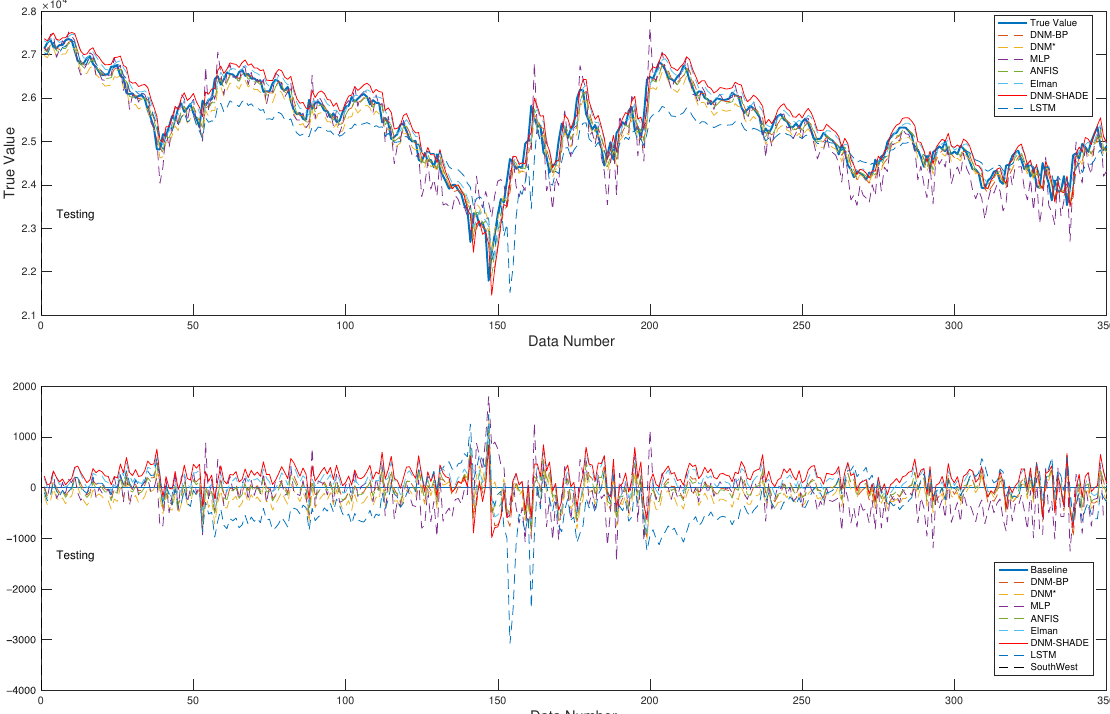
Figure 8. Prediction and deviation plots of seven types of time-series-forecasting models on